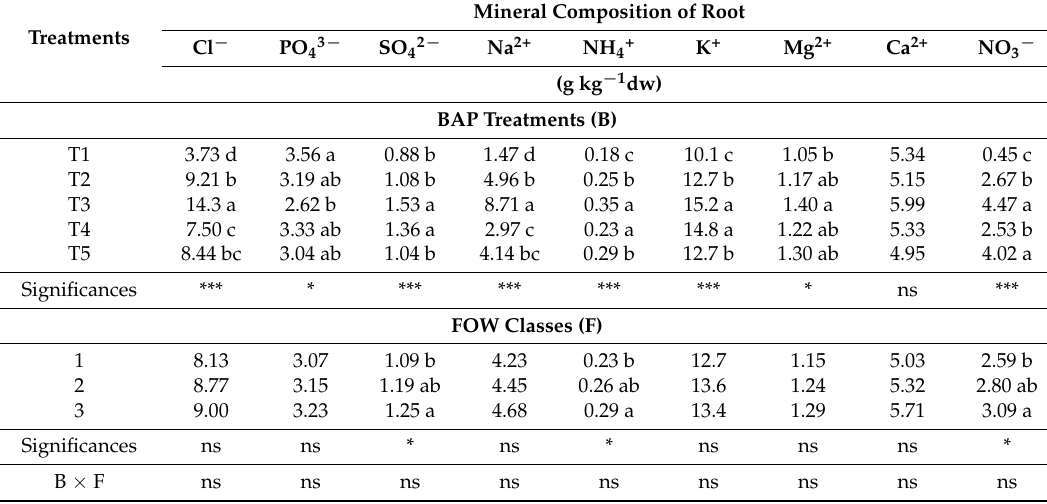
Table 8. Effect of BAP treatments on mineral contents in roots of the harvested offshoots from field mother plants.